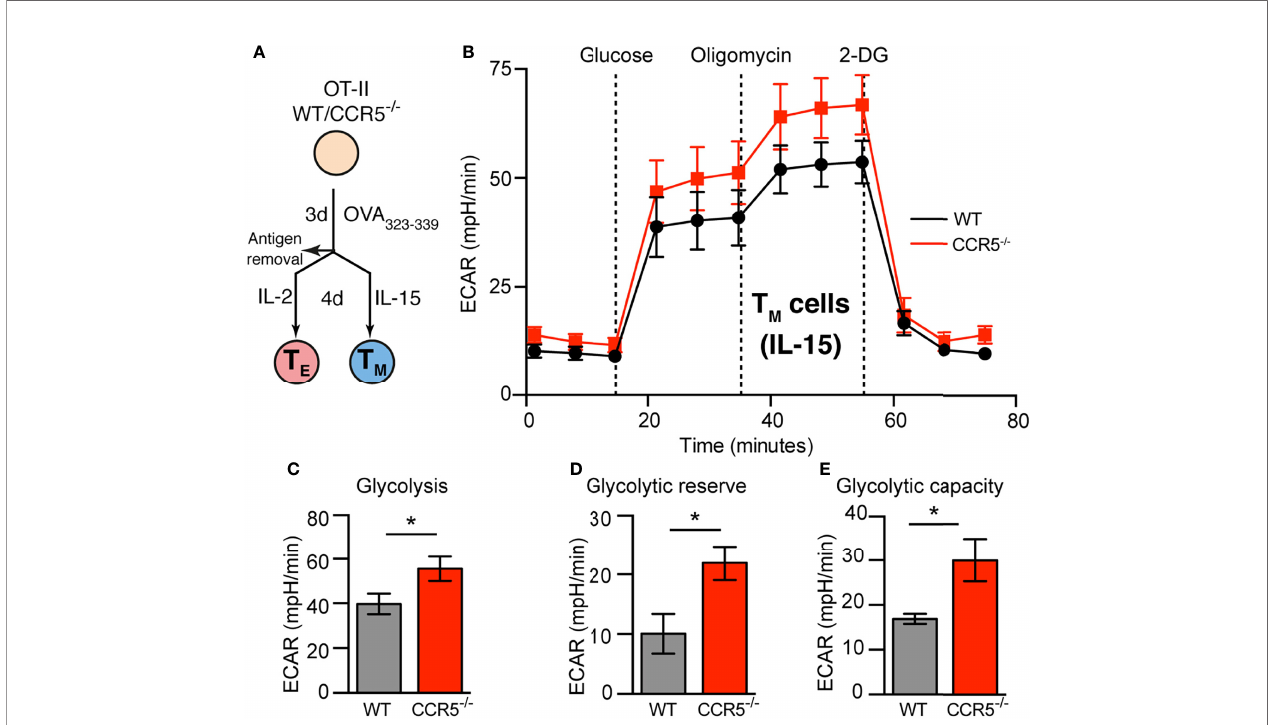
FIGURE 1 | CCR5 de fi ciency increases glycolytic metabolism in memory CD4 + T cells. (A). Diagram showing the ex-vivo activation and differentiation of primary CD4 + T cells (OT-II). (B) ECAR pro fi les of WT and CCR5 -/- T M (IL-15-expanded) lymphoblasts differentiated as in (A) , incubated in XF assay medium supplemented with 2 mM glutamine and 1 mM sodium pyruvate in the absence of CO 2 , and subsequently inoculated with glucose, oligomycin and 2-DG as indicated. (C – E). Determination of glycolysis (C) , glycolytic reserve (D) and glycolytic capacity (E) (details in Results ) from the ECAR curves obtained as in (B) . Data represent means ± SEM (n ≥ 9 from three independent experiments). *p < 0.05, two-tailed Student t